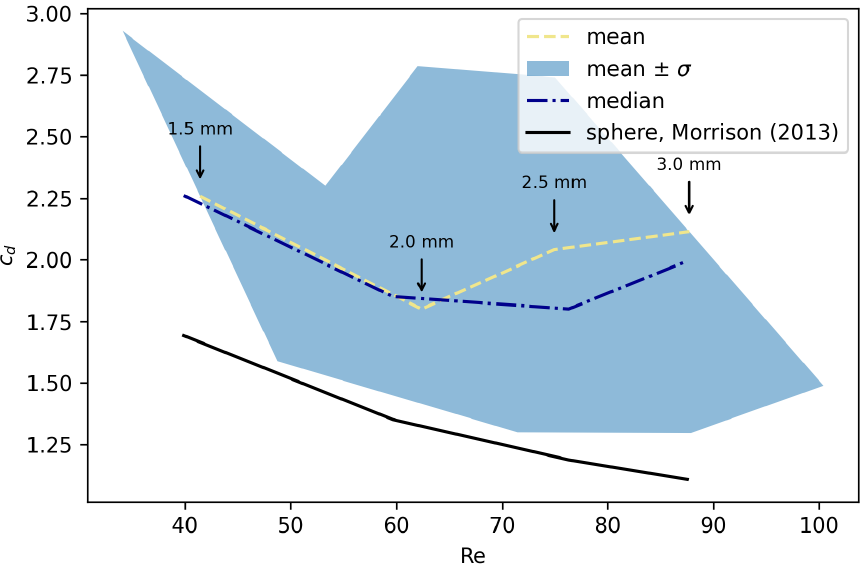
Figure 8. Correlation of drag coefficient and Reynolds number for the group C